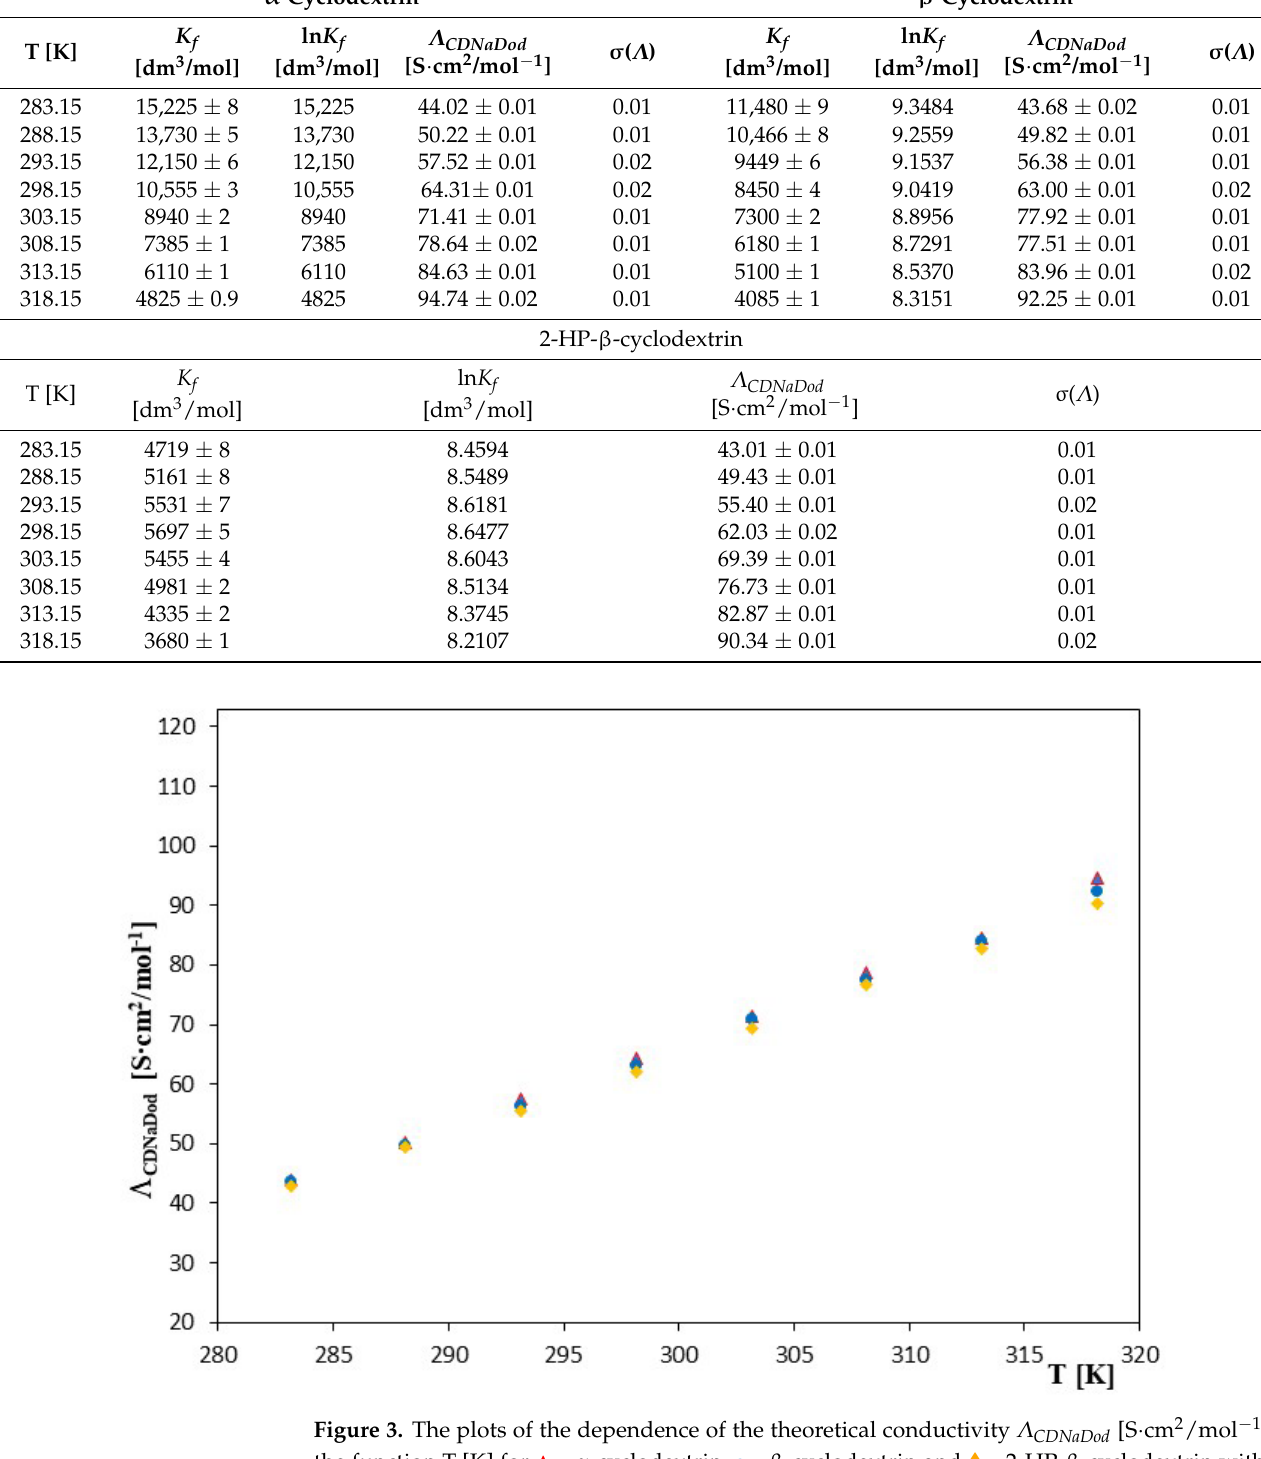
Figure 3. The plots of the dependence of the theoretical conductivity Λ CDNaDod [S · cm 2 /mol − 1 ] in the function T [K] for (cid:78) — α -cyclodextrin, • — β -cyclodextrin and (cid:7) —2-HP- β -cyclodextrin with all studied salts of dodecanoic